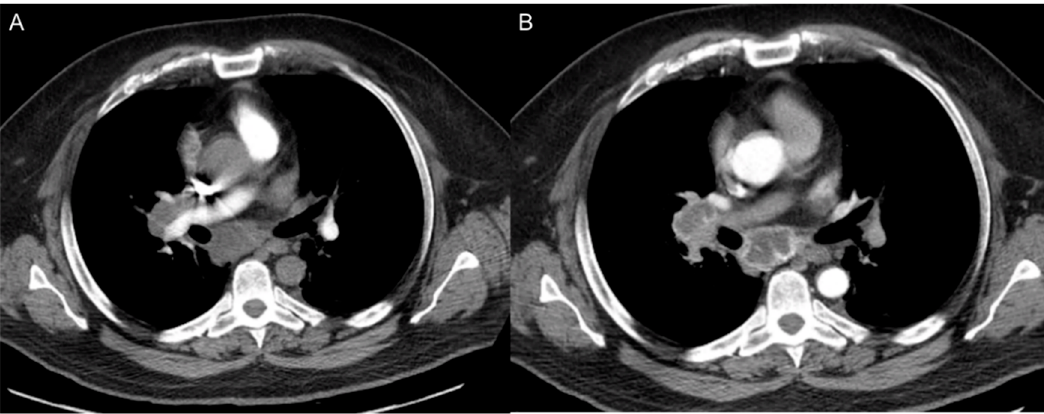
Figure 10. CT perfusion of a right hilar lesion was performed following administration of IV contrast. Displayed are selected sequential acquisitions ( A , B ) collected for measurement of perfusion parameters.